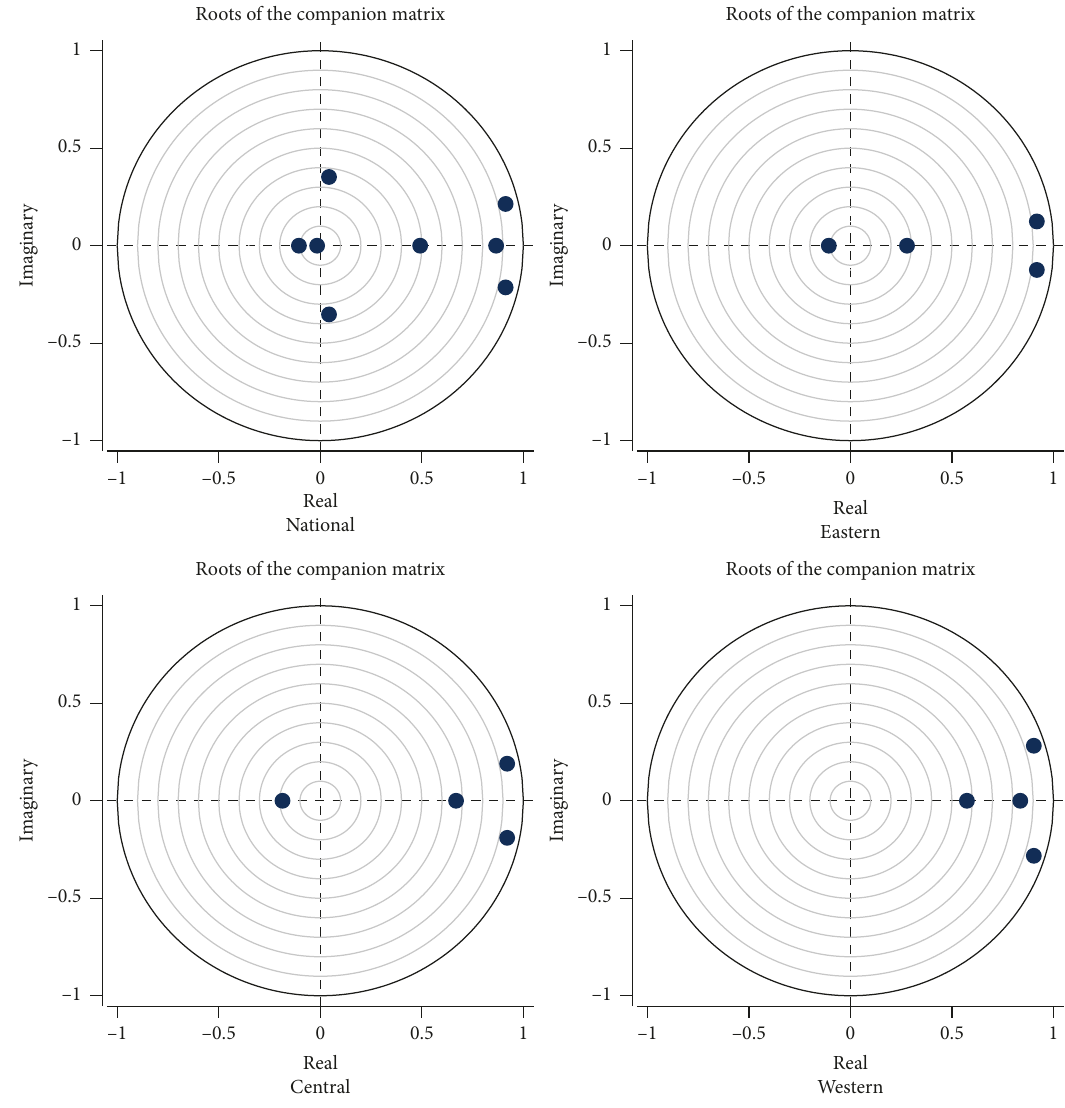
Figure 1: Stability test of the PVAR